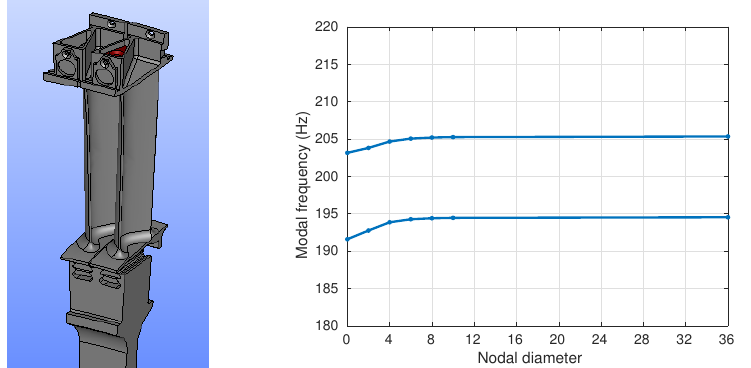
Figure 4. FEM model of the LPT rotor sector with mistuning mass shown in red ( left ), and vibration frequencies of the two first modal families ( right ) for the alternate mistuning configuration [01].